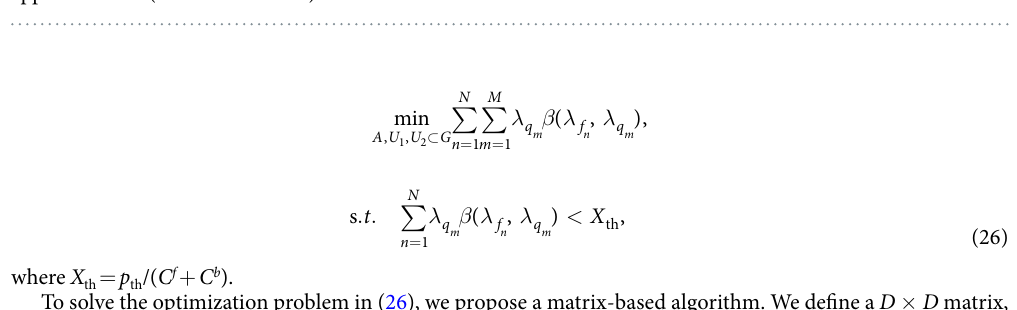
Figure 4. Secret key generation rate versus crosstalk photon count (blue solid curve) and its linear approximation (red dashed